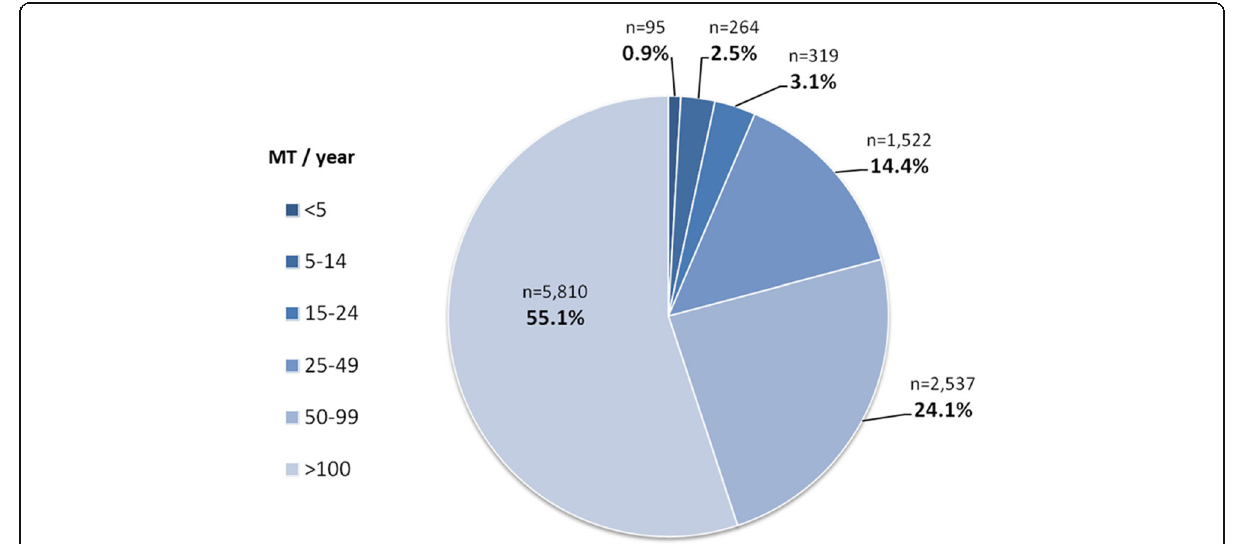
Fig. 5 Proportion of patients being treated in different centers, classified according to the number of MT performed per